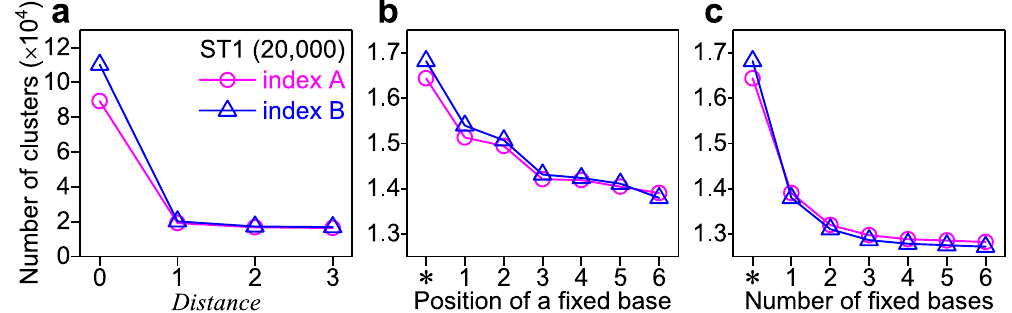
Figure 3. Analyses using Distance and fixed bases. The results of ST1 with index A (magenta circle) and index B (blue triangle) are shown. The number of random bases was 24. ( a ) Effect of clustering with different Distance on the number of clusters. ( b ) Dependence of the position of a fixed base with Distance = 3. An asterisk indicates no filtering. Only a single fixed base was used for filtering. ( c ) Dependence of the number of fixed bases with Distance = 3. The furthest base(s) from the sequencing primer site was used for